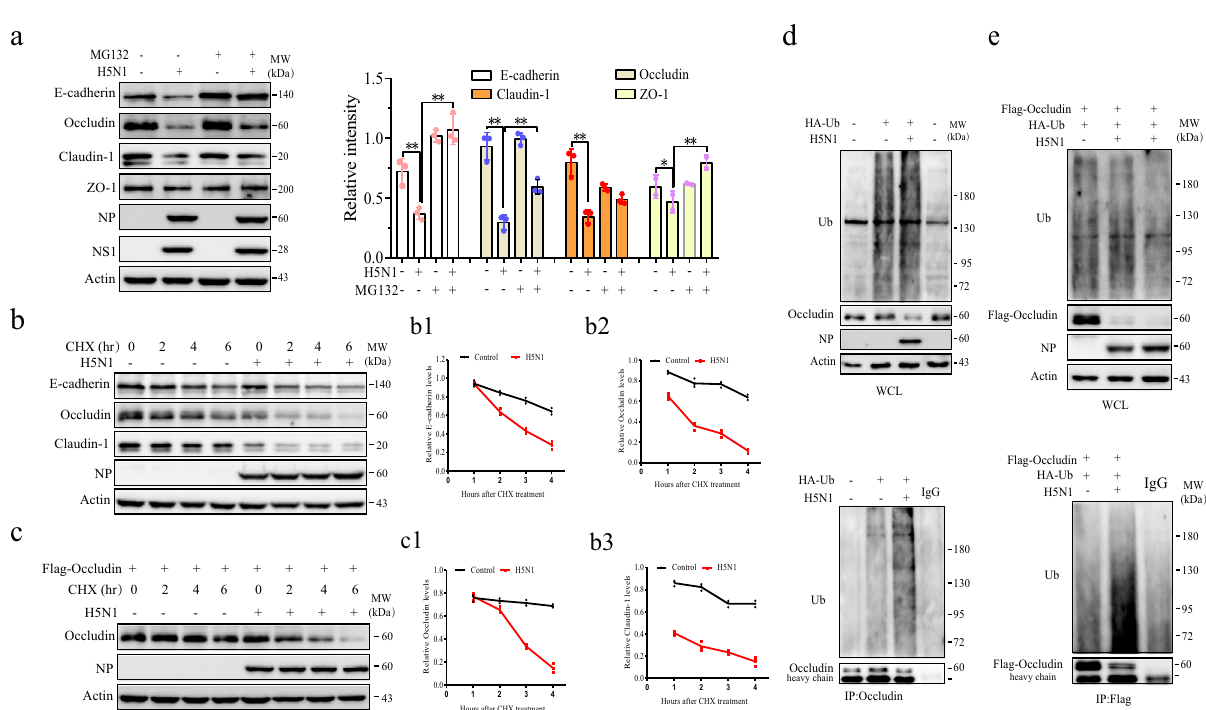
Fig. 2 H5N1 virus induces E-cadherin, occludin, and claudin-1 degradation. a H5N1 viruses accelerate the turnover of intercellular junction proteins. A549 cells infected with 1 MOI of H5N1 viruses were incubated for 24 h in the absence or presence of MG132 (10 μ M). Cell lysates were analyzed by Western blot for the levels of E-cadherin, occludin, claudin-1, ZO-1, and the viral NP and NS1 proteins with their speci fi c antibodies. b H5N1 viruses shorten the half- life of intercellular junction proteins. A549 cells were left uninfected or infected with H5N1 viruses (1 MOI). After incubation for 12 h, CHX (10 μ M) was added and incubated for the indicated lengths of time. Cell lysates were prepared and analyzed for E-cadherin, occludin, claudin-1, and NP by Western blot. c Quanti fi cation of relative E-cadherin levels (from b ). d Quanti fi cation of relative Occludin levels (from b ). e H5N1 viruses shorten the half-life of occludin. A549 cells were transiently transfected with the pcDNA3.1 expression vector encoding the FLAG-occludin gene. After incubation for 24 h, the cells were then left uninfected or infected with the H5N1 virus (1 MOI). After incubation for 12 h, CHX (10 μ M) was added and incubated for the indicated lengths of time. Cells were harvested and analyzed for occludin by Western blot. The density of bands was analyzed using NIH Image-J software and normalized by the arbitrary units of β -actin. f Quanti fi cation of relative Occludin levels (from e ). g Quanti fi cation of relative Claudin-I levels (from b ). Data presented in c , d , f , and g are the mean ± SD from one of three experiments in triplicate. h , i H5N1 virus induces occludin ubiquitination. A549 cells were transiently incubation for 24 h, the cells were left uninfected or infected with the H5N1 virus (1 MOI). After incubation for another 24 h, cell lysates were prepared and immunoprecipitated with an antibody against occludin ( h ) or FLAG ( i ). Whole-cell lysates (WCL) and immunoprecipitates were analyzed with antibodies against ubiquitin, NP, occludin, and β -actin. The data represent one of three independent experiments. *p < 0.05, **p <